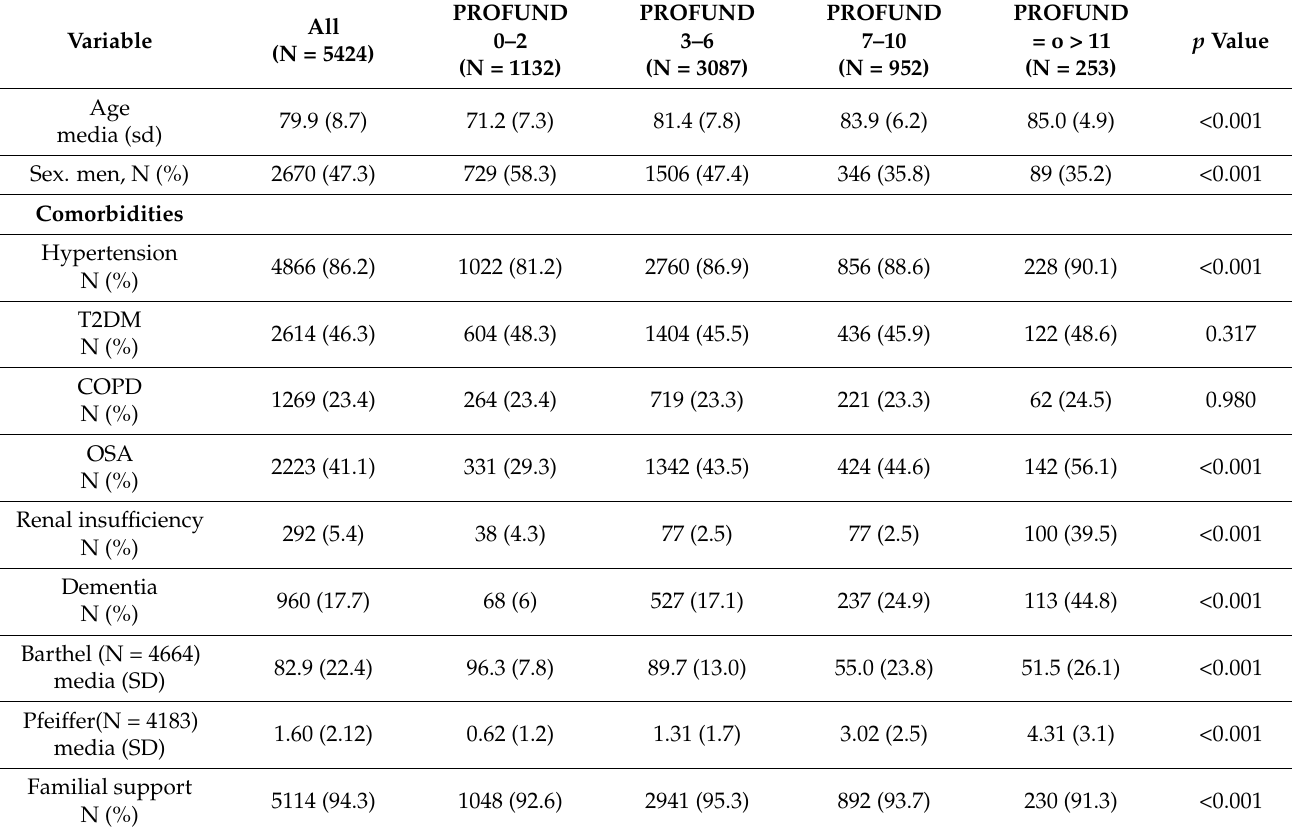
Table 2. Baseline characteristics of patients with heart failure according to the PRFUND